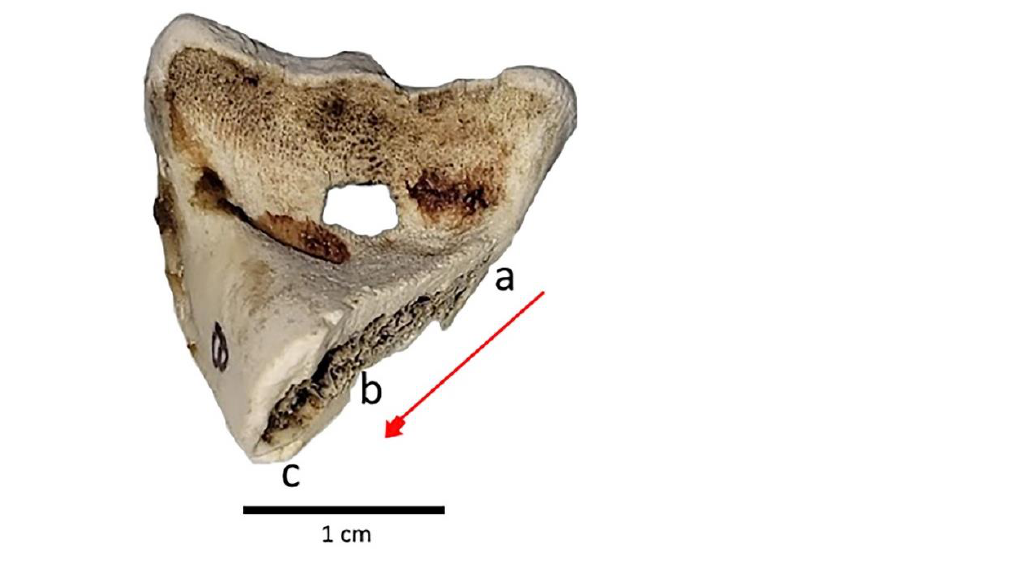
Figure 8. Class 5 chop mark made by the bronze axe on deer humerus (cBI 26); (a) place of impact (beginning of sheared surface), (b) kerf fracture (end of sheared surface), and (c) controlled breakage. The arrow indicates the direction of the axe.